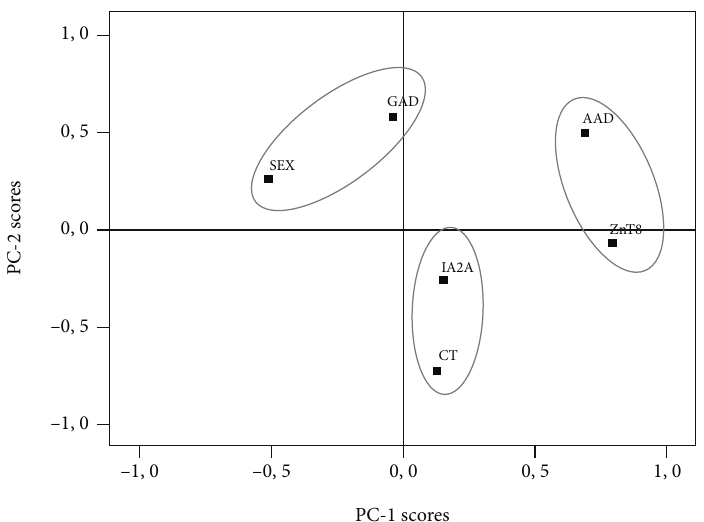
Figure 2: Score plot showing the relationship between the six variables and the two fi rst principal components (PC) of the T1D data set. The 3 circles represent a coherent group, suggesting distinct pathogenic pathways. SEX: gender; GAD: GADA titers; IA2A: IA-2A titers; C/T: rs13266634 genotype; AAD: age at diagnosis; ZnT8: ZnT8-Ab